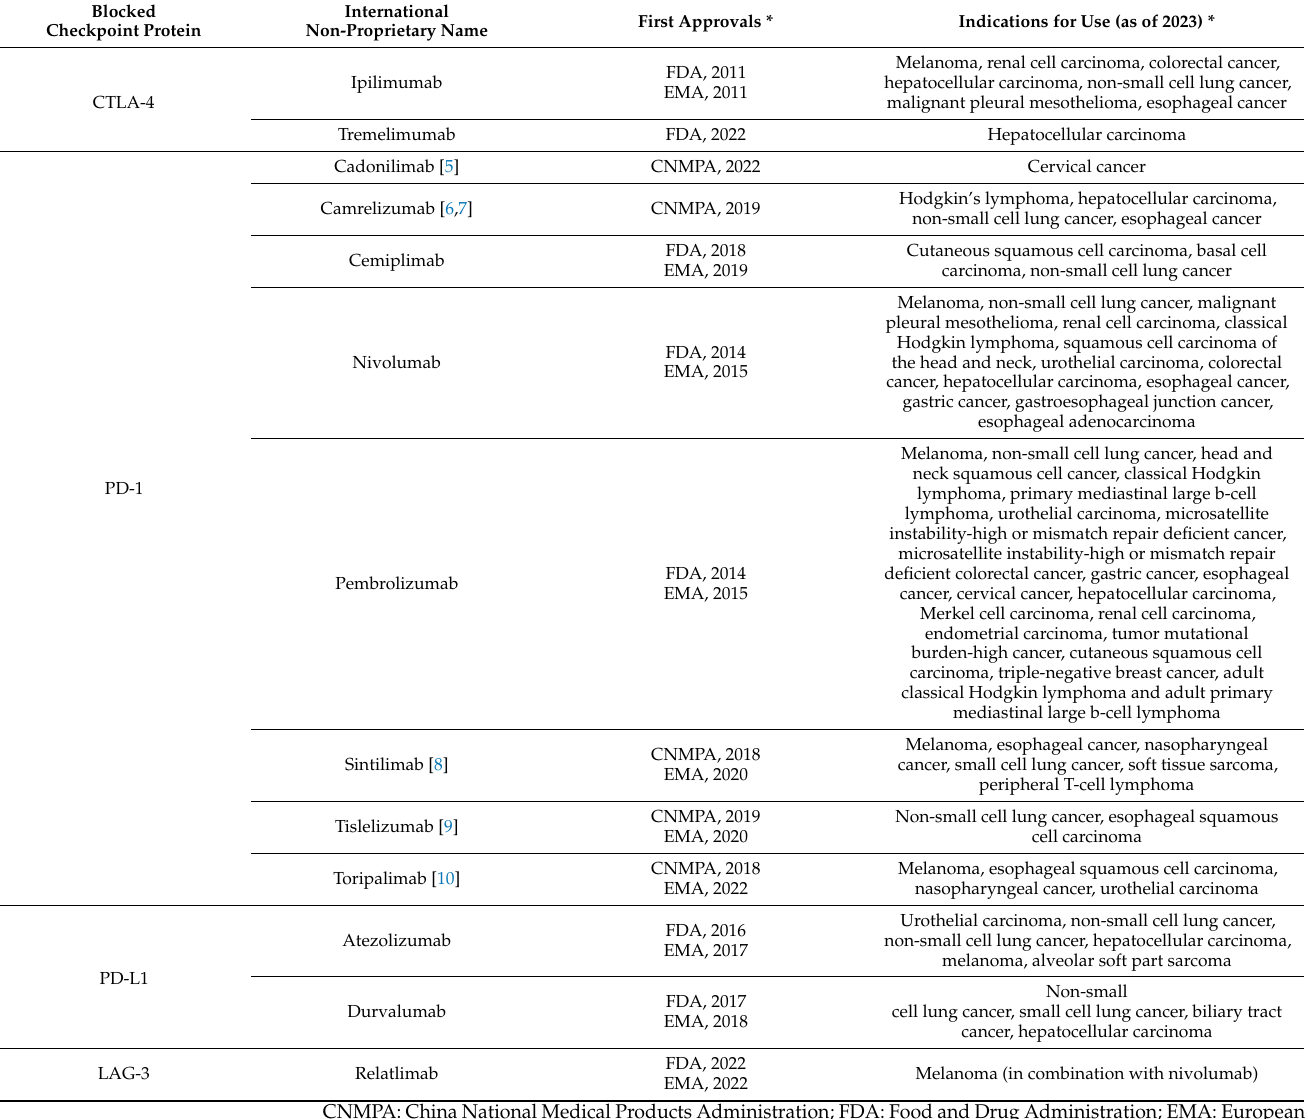
Table 1. ICIs in